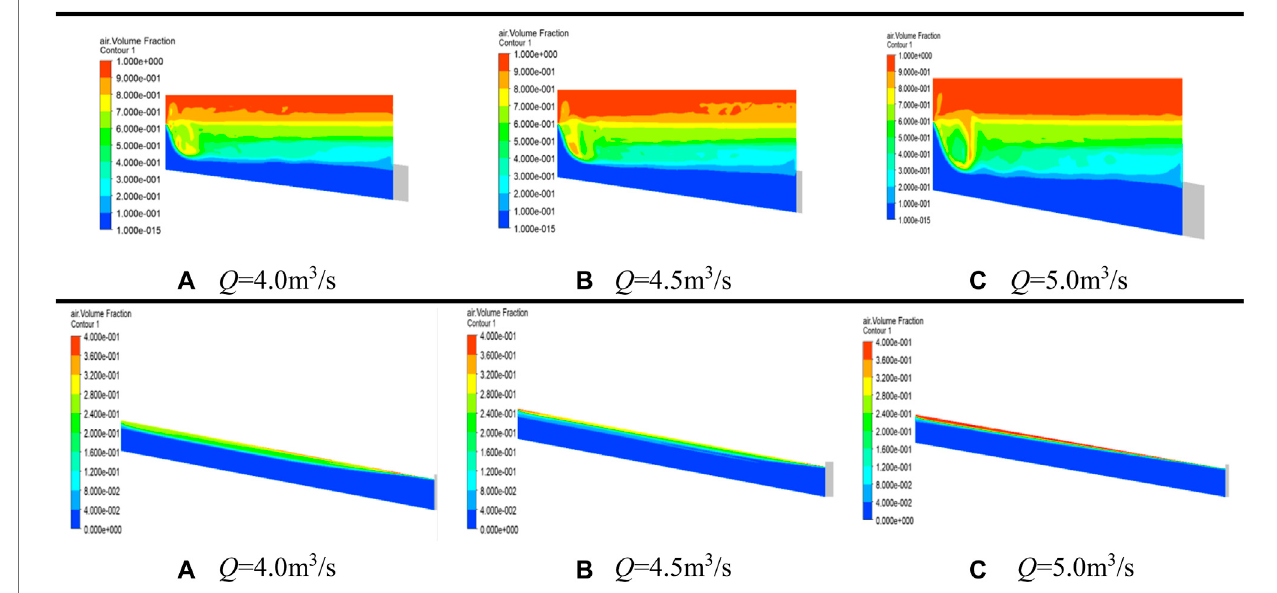
FIGURE 4 | The gas – liquid distribution of the inlet fl ow channel under different water levels. Q in represents different fl ow rates.